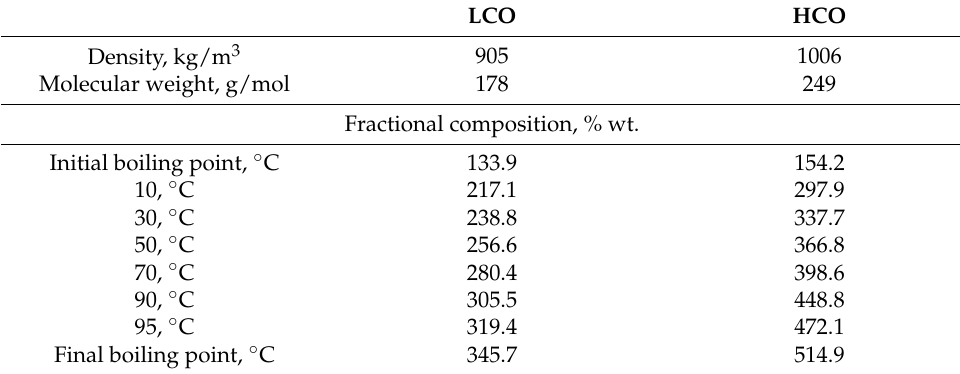
Table 2. Hydrocarbon medium